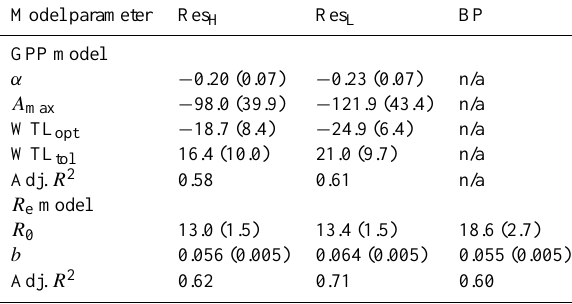
Table 2. Parameters for the gross primary production (GPP) and ecosystem respiration ( R e ) models in restoration treatments with high (Res H ) and low (Res L ) water table level (WTL) and bare peat (BP): α is the quantum use efficiency of photosynthesis (mgCµmolphoton − 1 ) ; A max is the maximum rate of photosyn- thesis at light saturation (mgCm − 2 h − 1 ) ; WTL opt is the WTL at which maximum photosynthetic activity occurs; WTL tol is the tol- erance, i.e., the width of the Gaussian response curve of GPP to WTL; R 0 is the respiration (mgCm − 2 h − 1 ) at 0 ◦ C; b is the sensi- tivity of respiration to air temperature; numbers in parenthesis indi- cate standard error; Adj. R 2 is the adjusted R 2 . Model parameter Res H Res